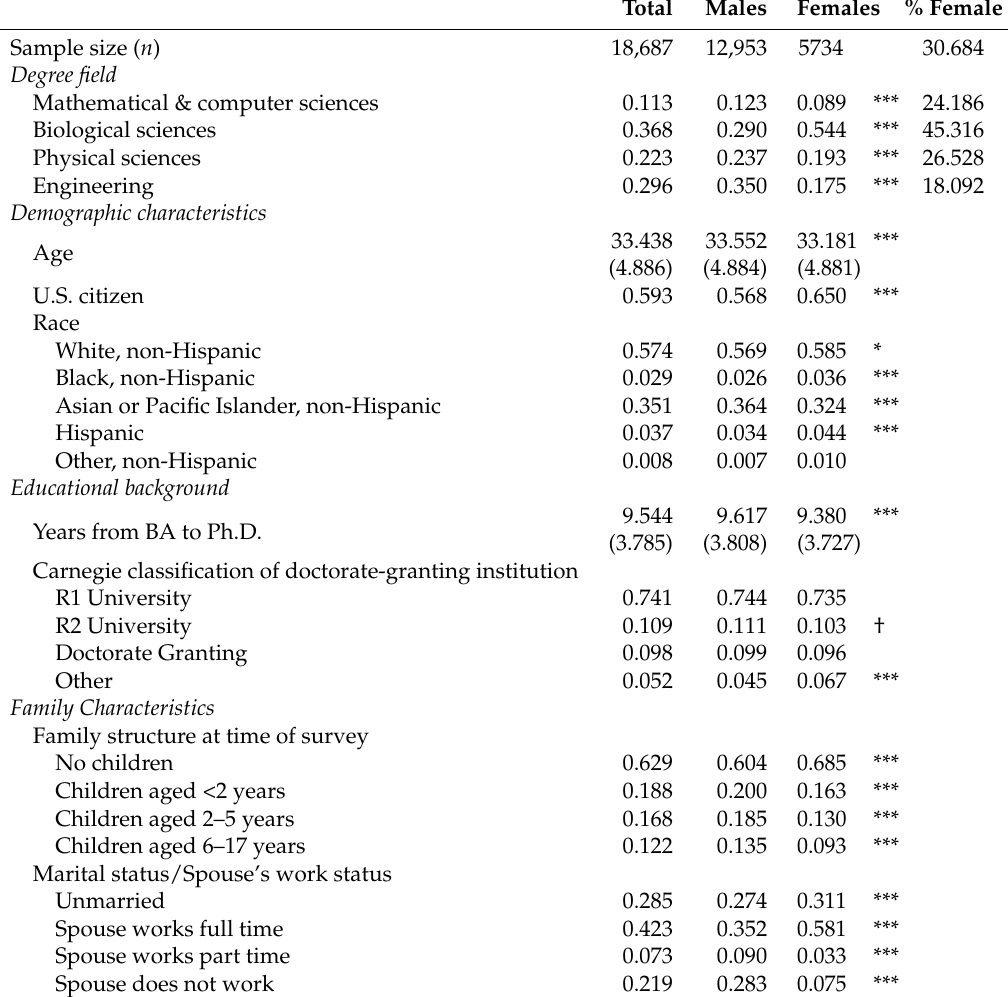
Table 1. Sample means for variables measuring degree field, demographic characteristics, educational background, and family structure for all recent doctorates, by